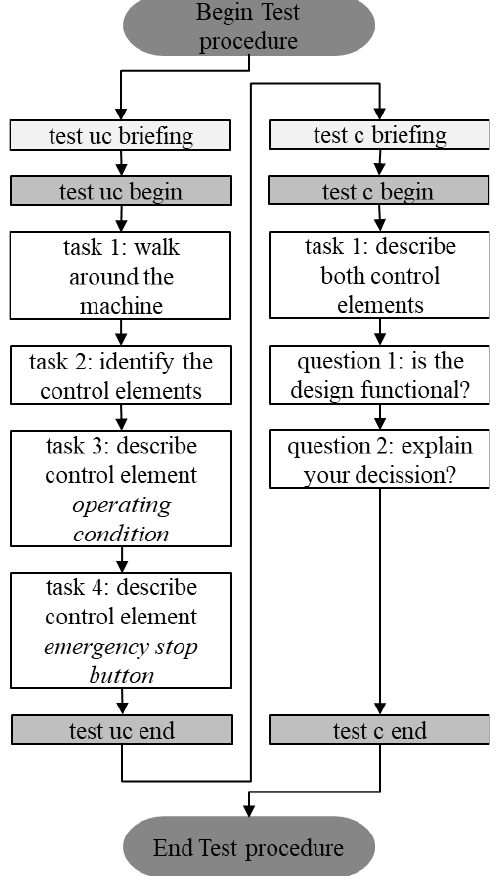
Figure 3. Flowchart of conscious (c) and unconscious (uc) test